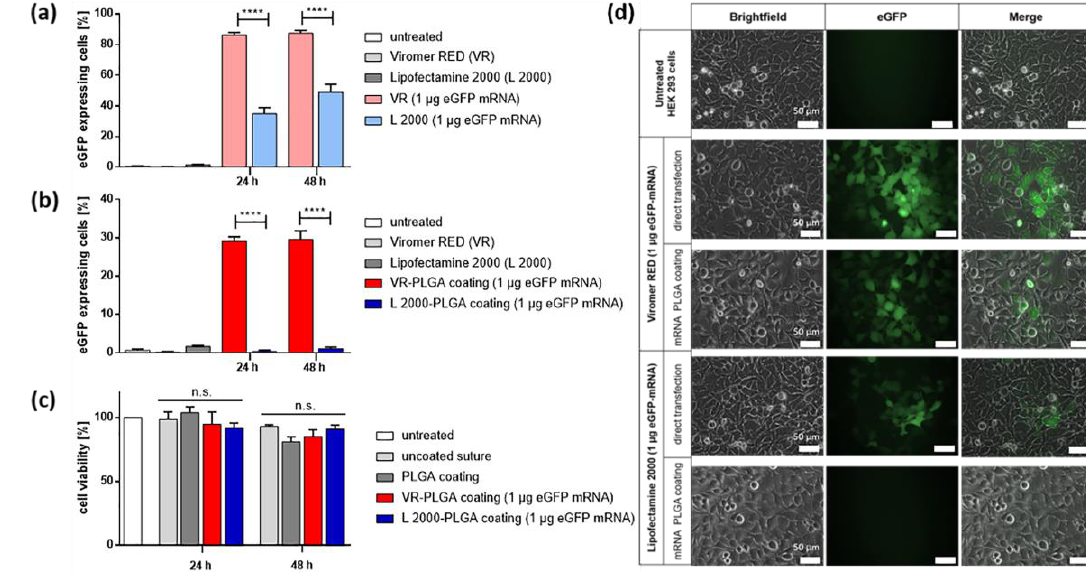
Figure 2. Comparison of di ff erent cationic transfection reagents for direct and indirect mRNA transfection of cells. Flow cytometric analysis of eGFP mRNA-transfected HEK293 cells using Viromer RED and Lipofectamine 2000 for direct transfection ( a ) or transfection via mRNA-PLGA coated sutures ( b ) 24 and 48 h post transfection ( n = 4; * * * * p < 0.0001). Determination of cell viability after exposition to di ff erent kinds of suture for 24 or 48 h ( c ) ( n = 4; n.s. = not significant). Fluorescence microscopic images of HEK293 cells 48 h after transfection by direct addition of 1 µ g of complexed mRNA or mRNA-coated sutures (d).